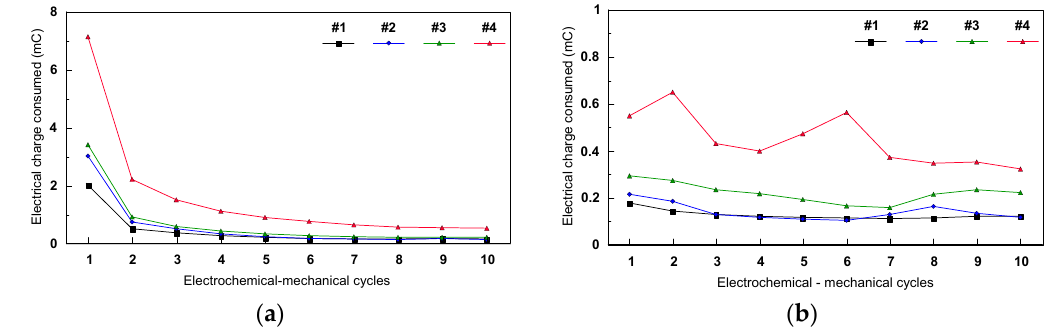
Figure 22. The fatigue corrosion behavior of Ti-based alloys in 9g/L NaCl during the mechanical cycles: ( a ) static and ( b ) dynamic cycles.